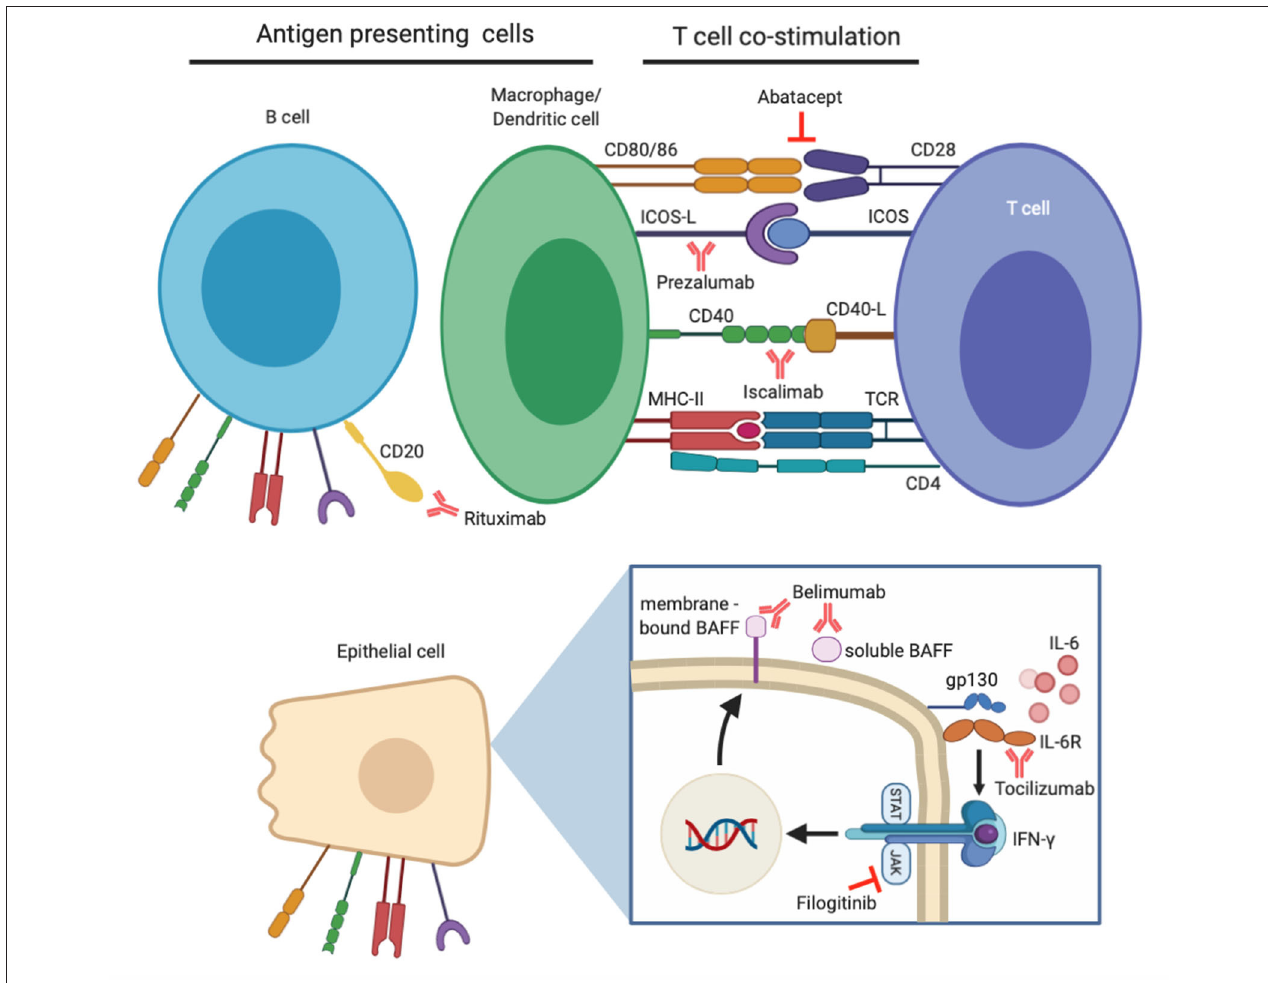
FIGURE 1 | Demonstration of biological therapies clinically evaluated for the treatment of primary Sjögren’s syndrome (pSS) and their target molecules. B-cell hyperactivity is a major contributor to pSS pathogenesis, and their numbers can be depleted by anti-CD20 antibody rituximab. B-cells alongside other professional (macrophages/dendritic cells) and non-professional (epithelial) antigen presenting cells are involved in enhanced T-cell co-stimulation in pSS. Specific co-stimulatory pathways can be inhibited by abatacept, prezalumab, and iscalimab. Pro-inflammatory effects of cytokine IL-6 can be prevented by tocilizumab therapy, whilst effects of IFN- γ can be mitigated by inhibition of the JAK/STAT pathway. An additional downstream effect of this is prevention of BAFF expression, which can itself be targeted by belimumab